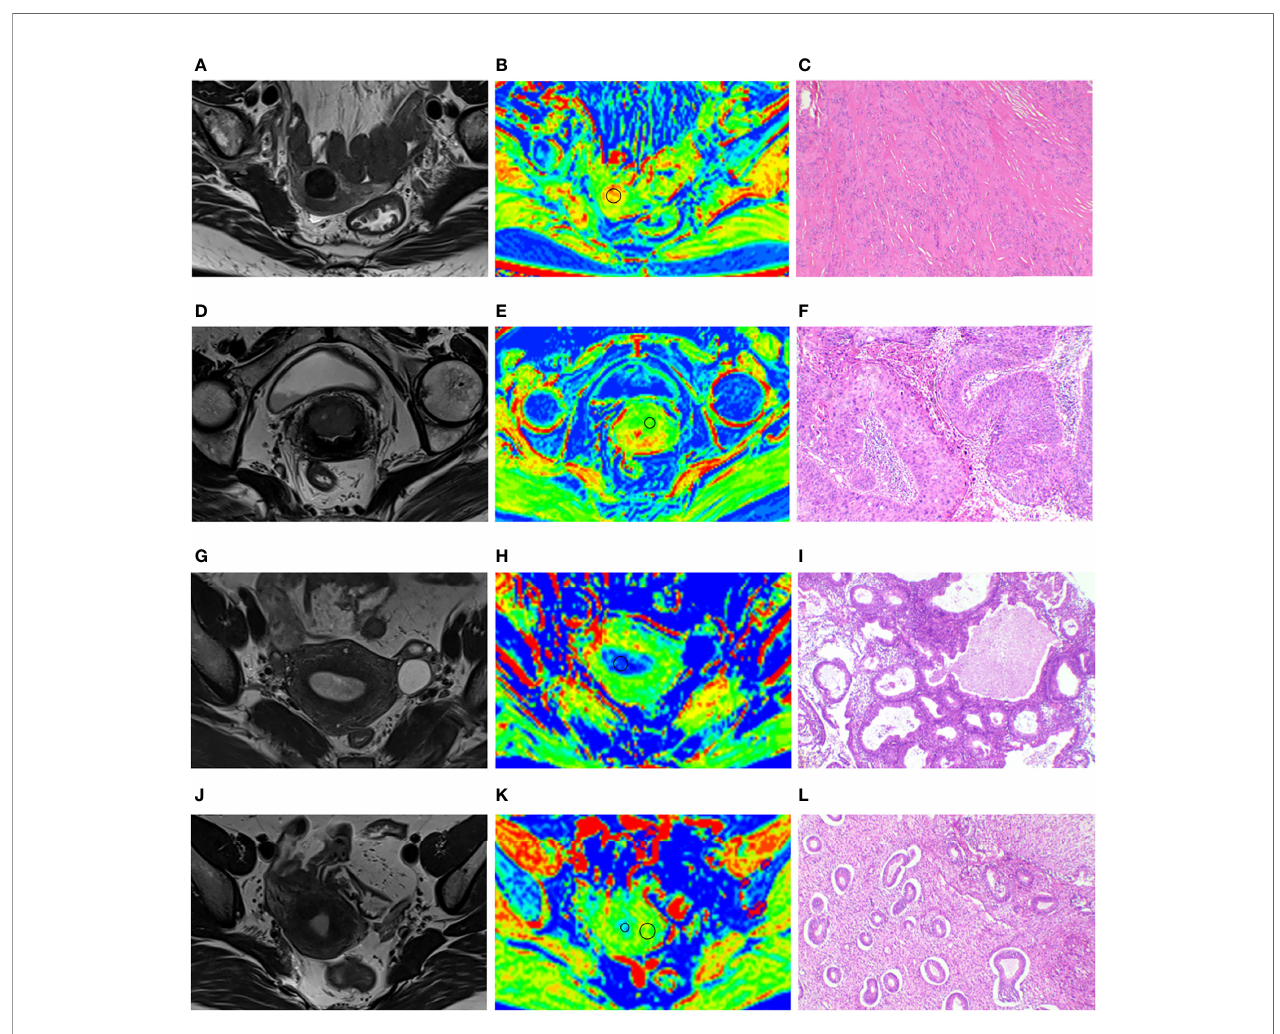
FIGURE 4 | (A – C) A 64-year-old patient with uterine leiomyoma, MTR of leiomyoma is 13.01. (D – F) A 65-year-old patient with cervical cancer; MTR value of cervical cancer is 7.46. (G – I) A 49-year-old patient with endometrial hyperplasia; MTR value of endometrial hyperplasia is 6.93. (J – L) A 40-year-old patient with carcinoma in situ of cervix; MTR values of normal endometrium and myometrium are 7.17 and 12.03. Panels (A, D, G, J) represent uterus-axial T2WIs. Panels (B, E, H, K) represent uterus-axial pseudo-color MTR maps. Panels (C, F, I, L) represent hematoxylin and eosin staining map (40×) of the